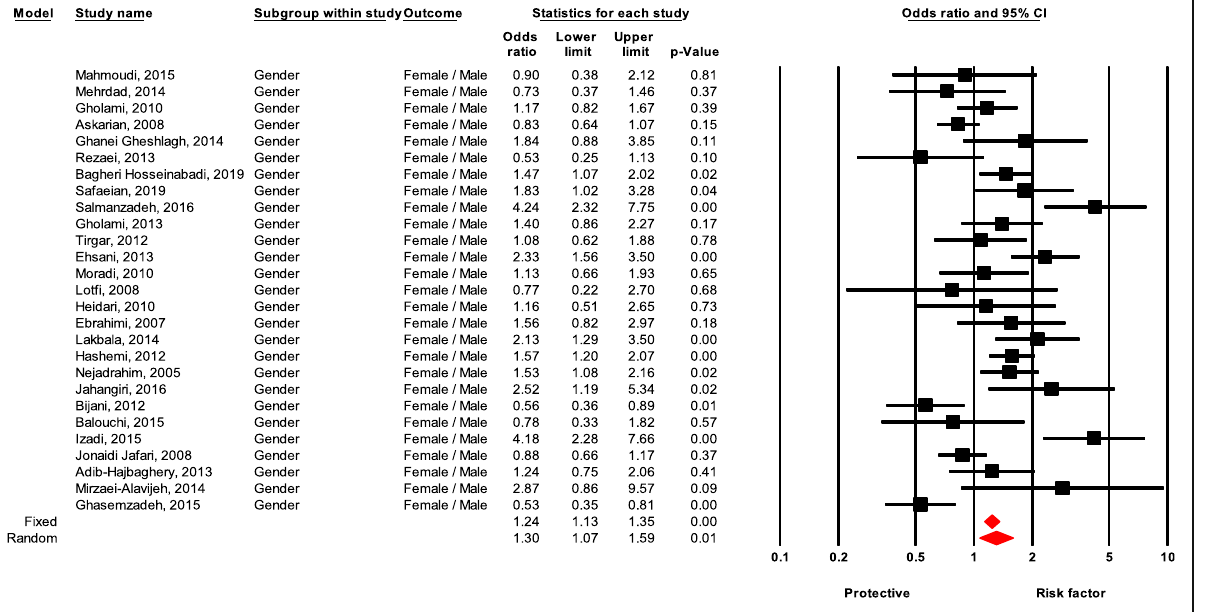
Fig. 2 Forest plot for relationship between gender and risk of NSI in Iran